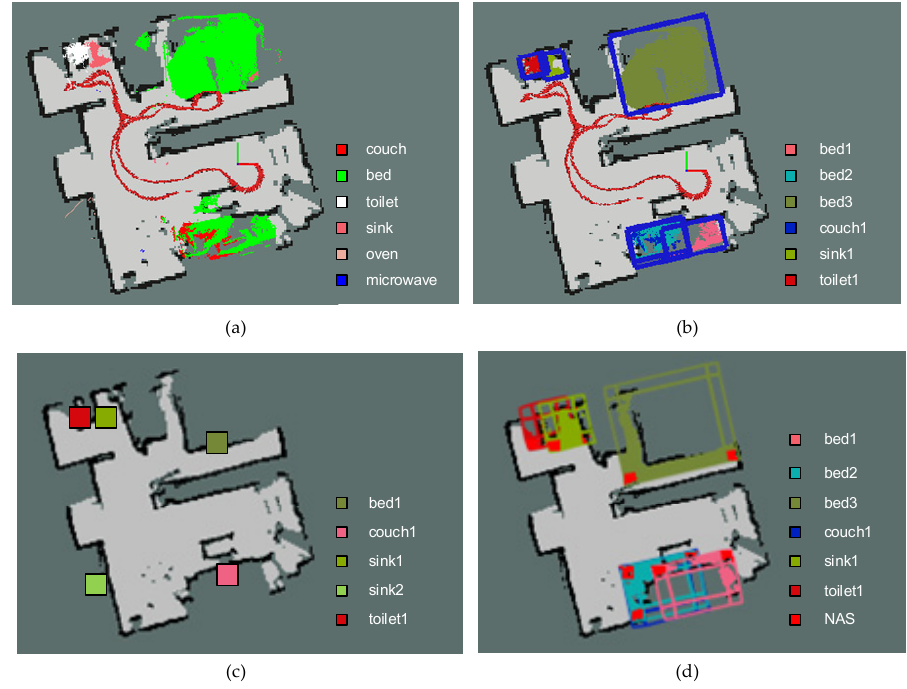
Figure 15. The results of the rx2 scene: ( a ) original point cloud, ( b ) point cloud with bounding rectangles, ( c ) the ground truth, and ( d ) the object semantic grid map. Table 2. The statistical results of the rx2 scene.